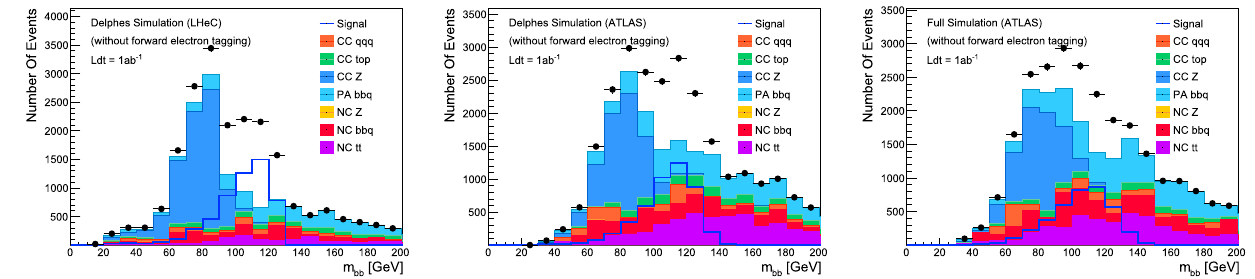
Fig. 5 Invariant di-jet mass of two selected b -tagged jets for the signal as well as the CC, NC and photo-production background processes for the LHeC detector (left), the fast simulated ATLAS detector (middle) and the fully simulated ATLAS detector (right)